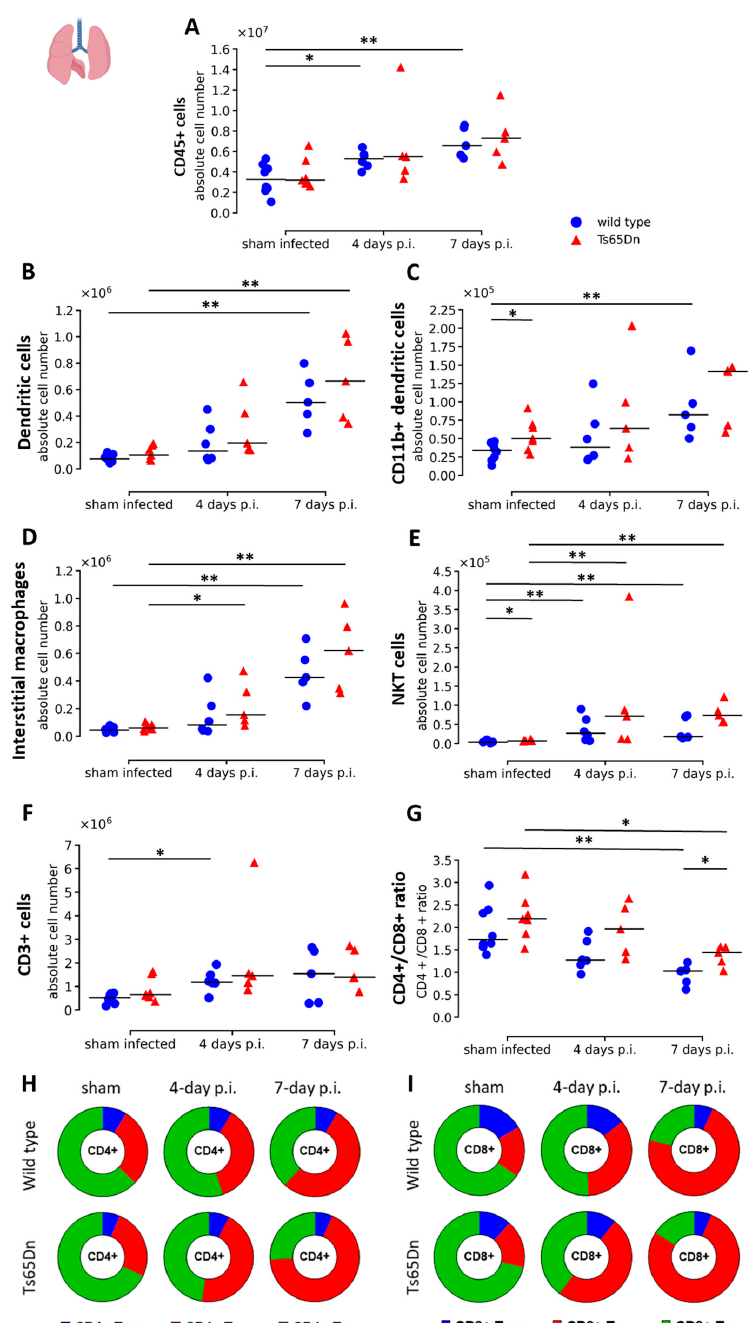
Figure 6. Flow cytometric analysis of pulmonary leukocytes in wild type and Ts65Dn mice after sham, four days or seven days rhRSV-Luc infection. ( A ) The absolute number of leukocytes (CD45+). ( B ) Lung dendritic cells (DCs; CD45+ Lin − SiglecF − MHC-II+ CD11c+). ( C ) CD11b+ DC (CD45+ Ly6G- SiglecF − MHC-II+ CD11c+ CD11b+). ( D ) Lung interstitial macrophages (CD45+ Lin − Ly6G- CD11bhi MHC-II+ CD64+ CD24 − ). ( E ) Lung NKT cells (CD45+ CD3+ NK1.1+) were presented as individual values and group median. ( F ) Lung T lymphocytes (CD3+) were presented as absolute number. ( G ) The ratio of CD4+ over CD8+ cells T cells and the proportions of, respectively, ( H ) CD4+ and ( I ) CD8+ Tcm (CD44+ CD62L+; blue), Te (CD44+ CD62L − ; red), and Tn (CD44 − CD62L+; green) of the total T-cell population are shown and presented as proportion of total CD4+ and CD8+ T cells. * p < 0.05, ** p <